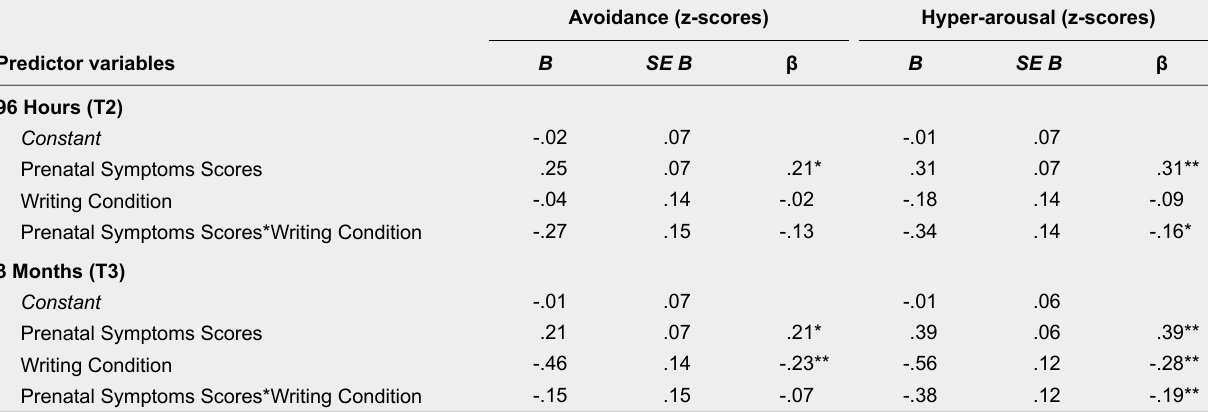
Regression Analysis Predicting Avoidance and Hyper-Arousal Scores at 96 Hours (T2) and at 3 Months (T3)